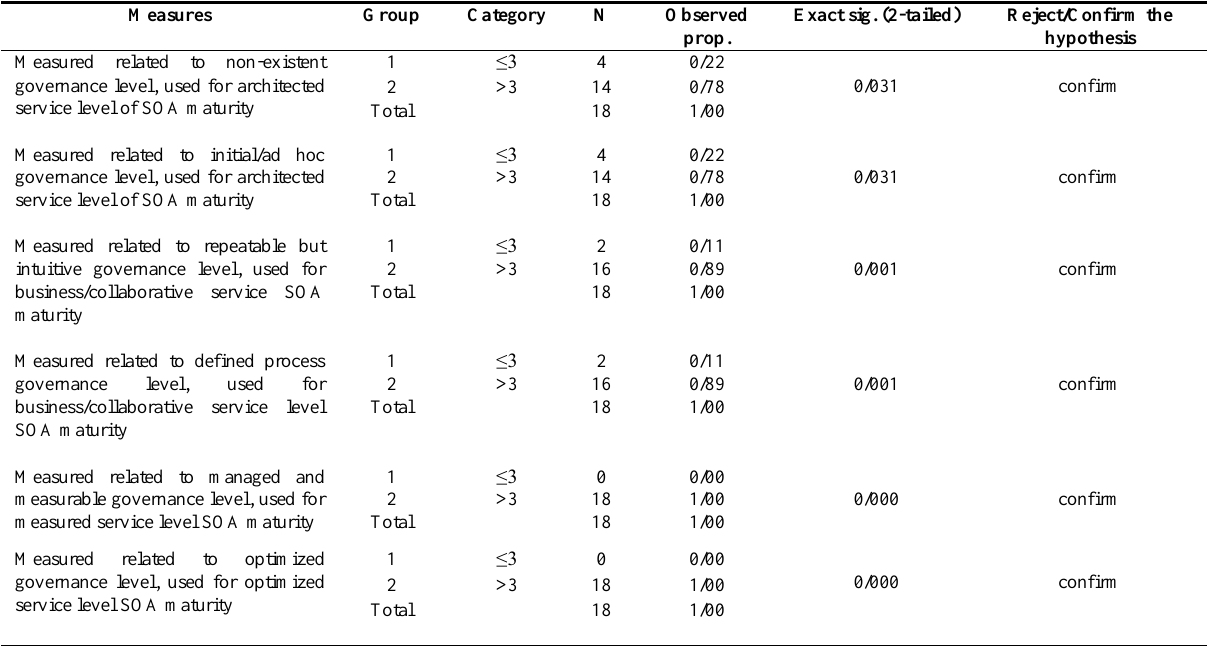
Table 9: Result of testing hypothesis of D section (sig. level